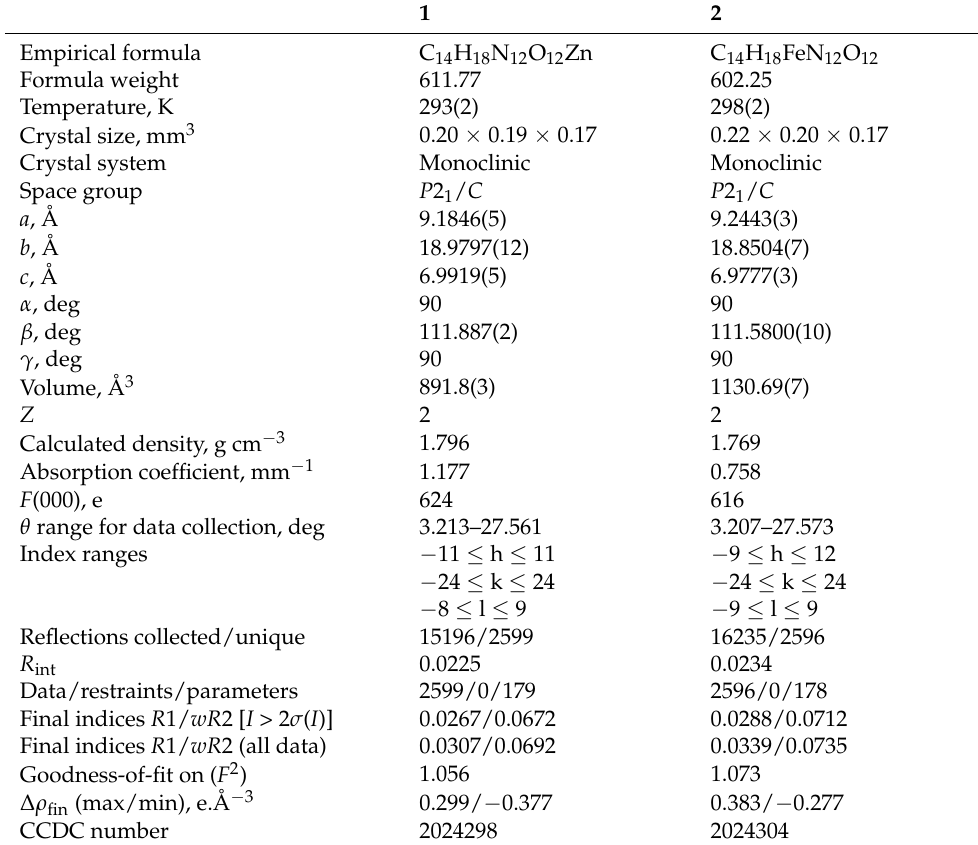
Table 1. Crystal data and structure refinement data of complexes 1 and 2